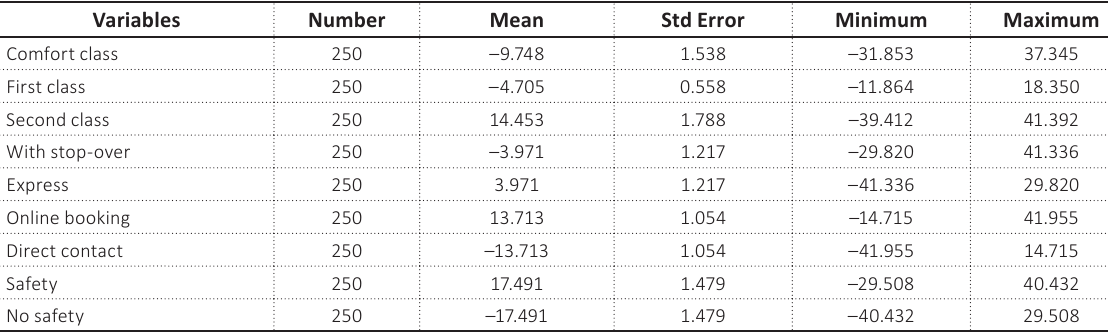
Table 5. The estimated average utilities of different modalities